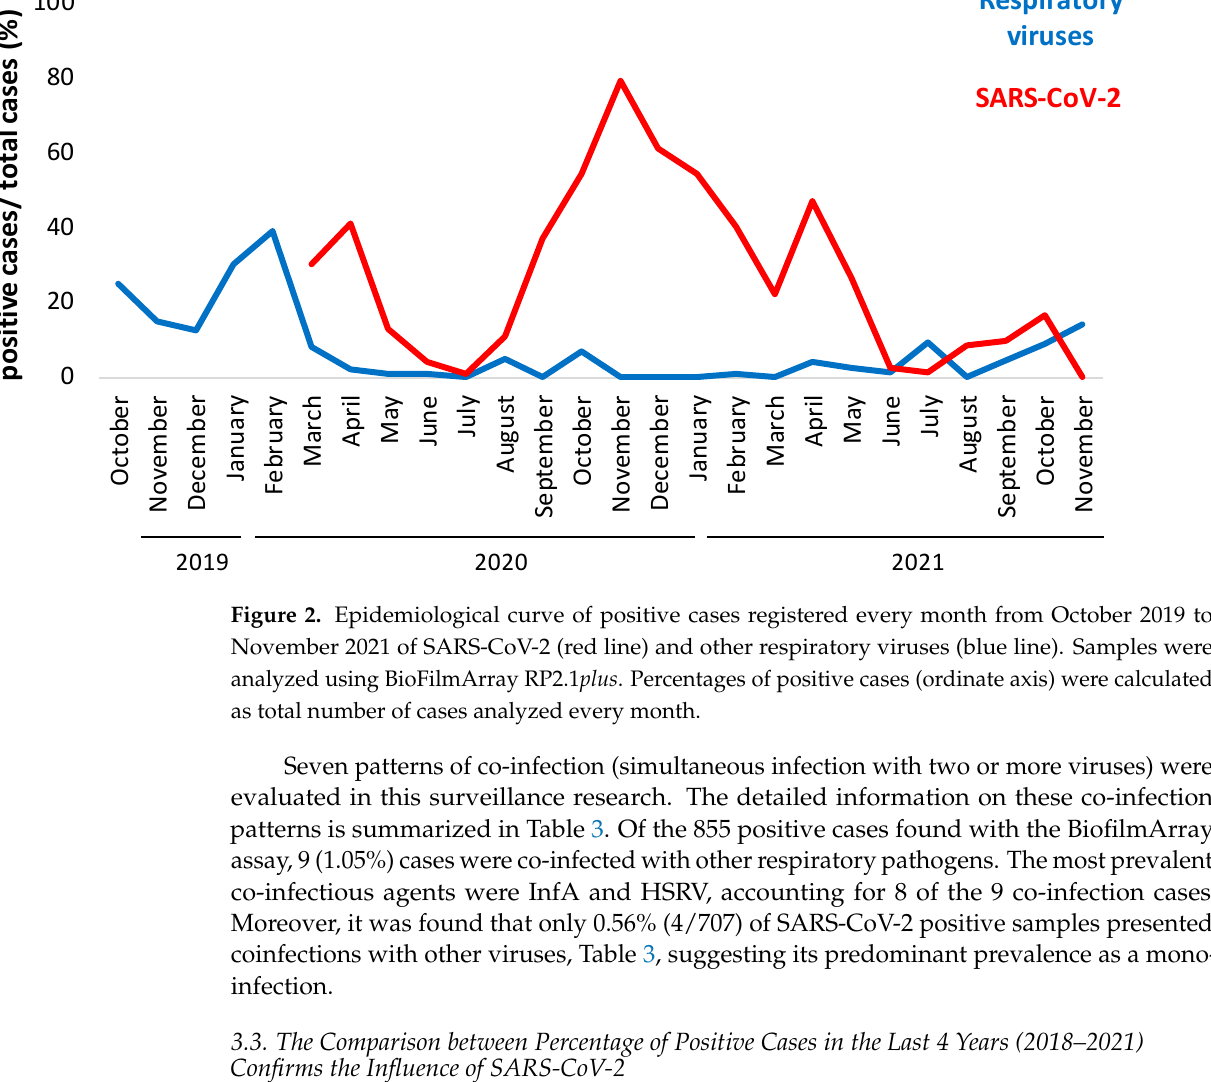
Table 3. Double and triple co-infections (October 2019–November 2021).